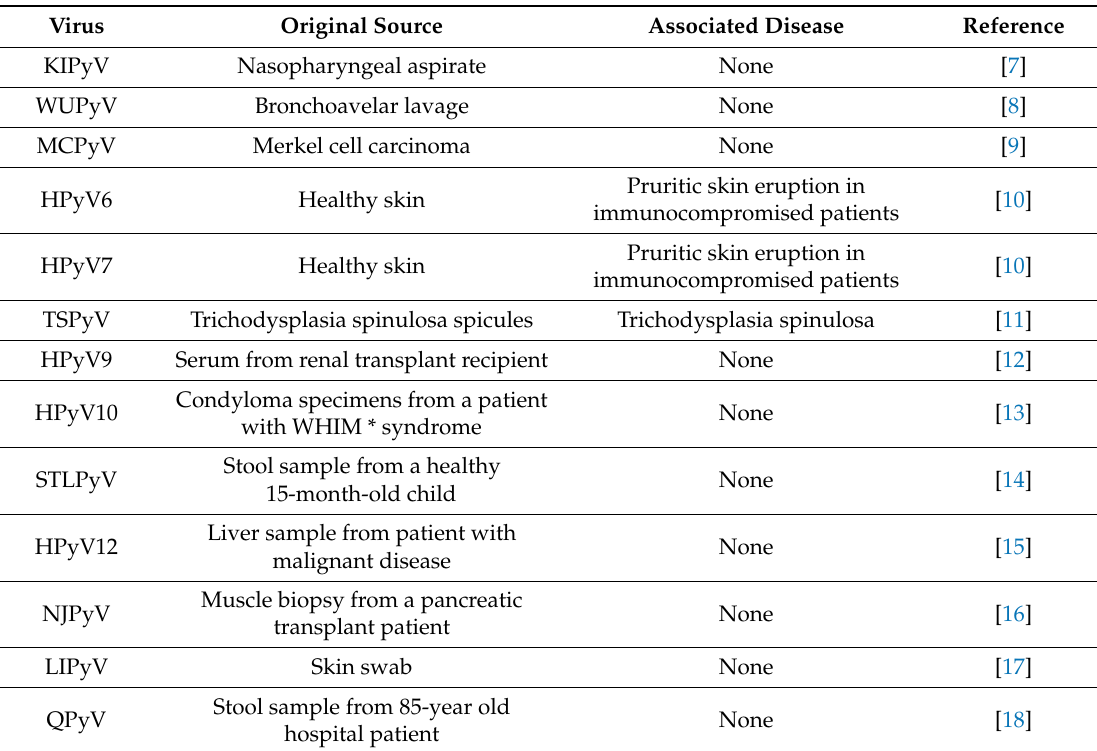
Table 1. The novel human polyomaviruses, their original source of isolation and their association with human